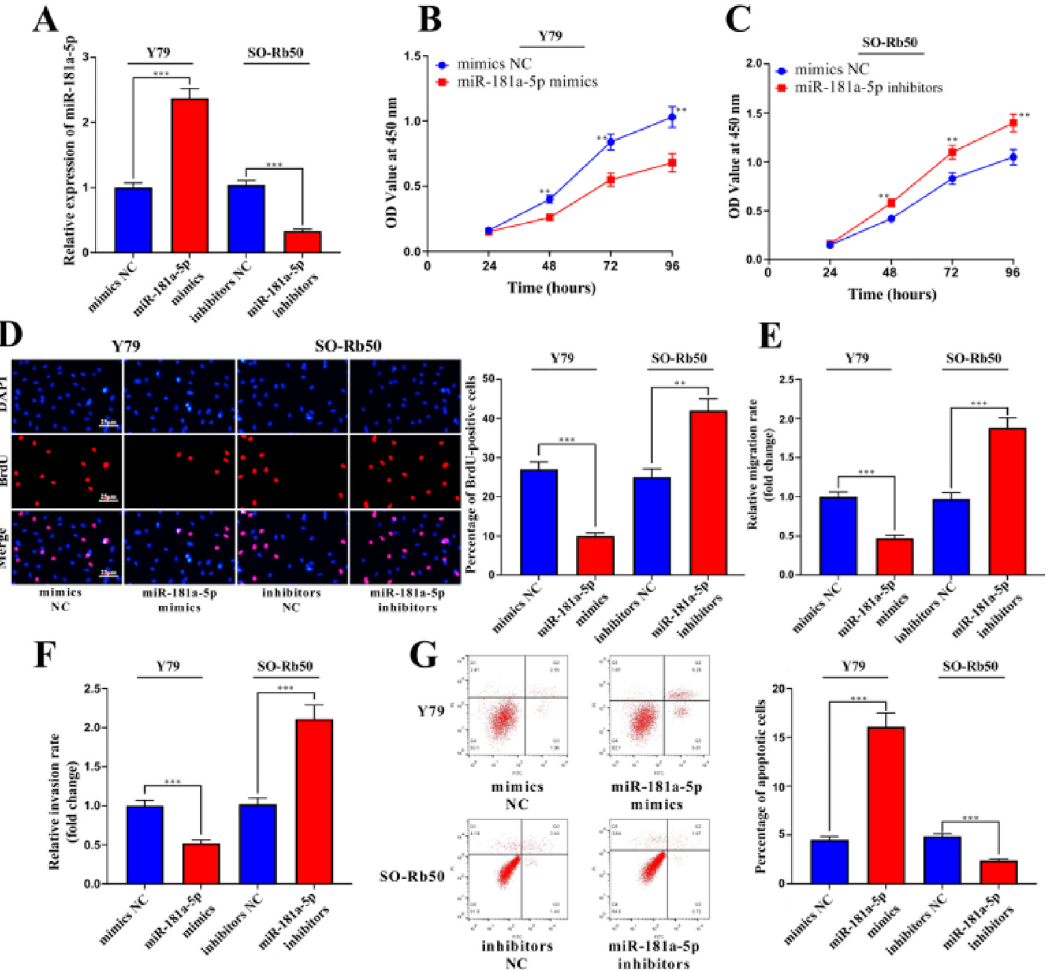
Fig. 3. MiR-181a-5p inhibits RB cell proliferation and metastasis and induces cell apoptosis. (A) qRT-PCR showed that miR-181a-5p was upregulated in Y79 cells transfected with miR-181a-5p mimics and downregulated in SO-RB50 cells transfected with miR-181a-5p inhibitors. (B-D) Cell Counting Kit 8 (CCK-8) and 5 ′ -bromo-2 ′ -deoxyuridine (BrdU) assays showed that miR-181a-5p mimics inhibited the cell proliferation, while miR-181a-5p inhibitors pro- moted the cell proliferation. (E-F) Transwell assay showed that miR-181a-5p mimics inhibited the migration and invasion of Y79 cells, while miR-181a-5p inhibitors promoted the migration and invasion of SO-RB50 cells (magni fi cation: × 200; bar: 25 μ m). (G) Flow cytometry showed that miR-181a-5p mimics promoted apoptosis in Y79 cells, while miR-181a-5p inhibitors inhibited the apoptosis of SO-RB50 cells. Mimics NC indicates the negative control of miR- 181a-5p mimics, and inhibitor NC indicates the negative control of miR-181a-5p inhibitors. The data are shown as the mean ± standard deviation from three independent experiments. **p < 0.01 and ***p <